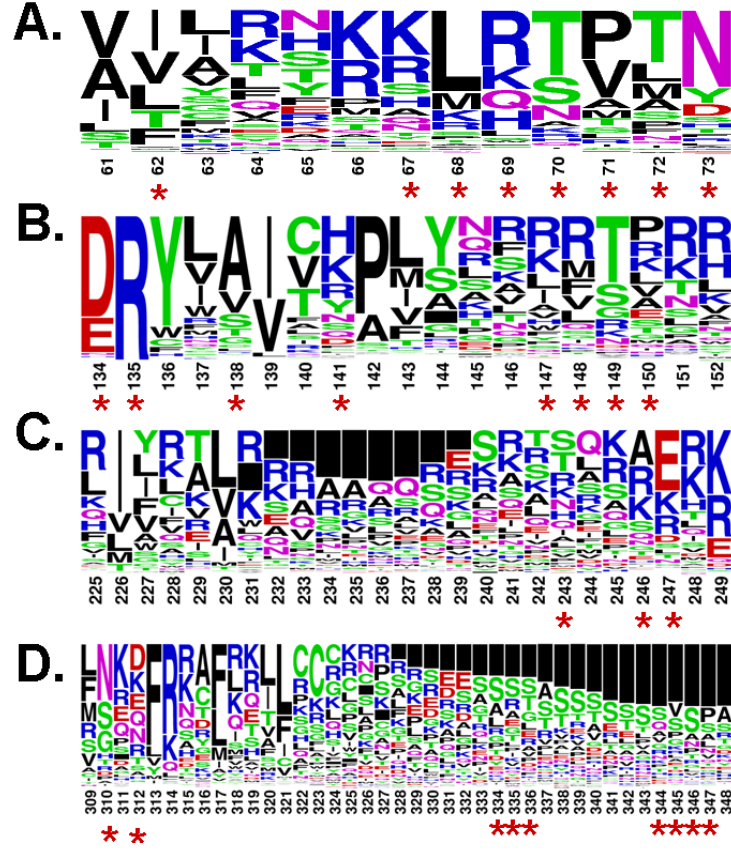
Figure 3. Frequency plot of the cytoplasmic region of Class A GPCRs. The frequency of residues corresponding to (A) CP loop 1, (B) CP loop 2, (C) CP loop 3, and (D) C-terminus of class A GPCRs. The amino acids at each position in the plot are colored based on their amino acid properties. A similar color between two amino acids at a particular position indicates that they both belong to the same group. The residues that were predicted bind to Ce6 on rhodopsin in the CP domain are indicated by red asterisks. The frequency plots were generated using the weblogo online tool